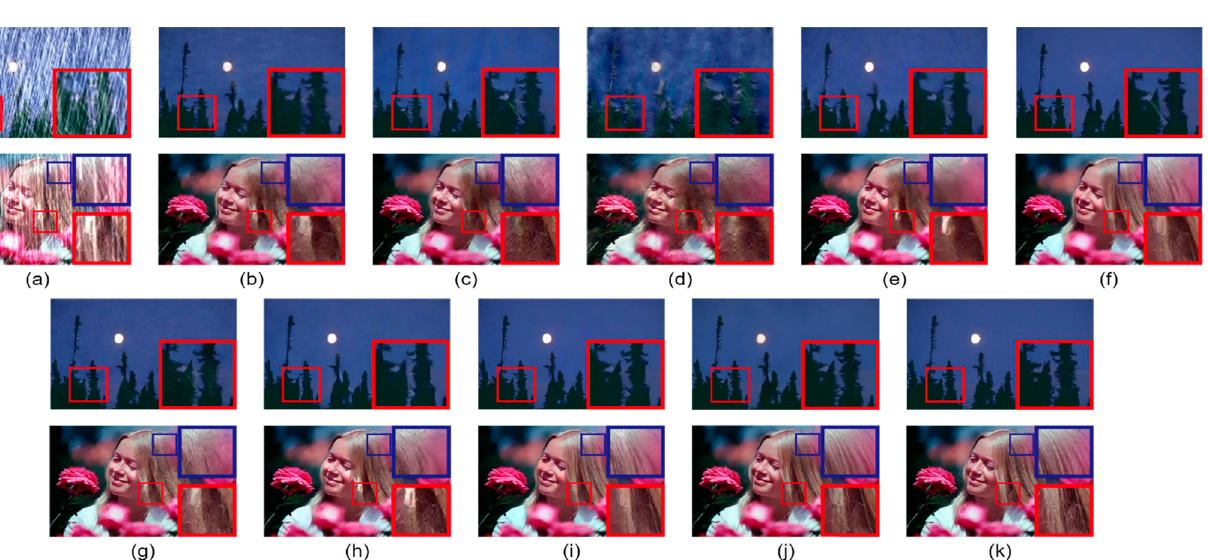
Figure 8. Deraining task performance of the proposed MARCAFNet and state-of-the-art methods when using the Rain100L dataset. ( a ) Rainy image, ( b ) RESCAN, ( c ) PReNet, ( d ) LPNet, ( e ) MSPFN, ( f ) MPRNet, ( g ) VRGNet, ( h ) PCNet, ( i ) RAiANet, ( j ) MARCAFNet, and ( k ) ground truth.